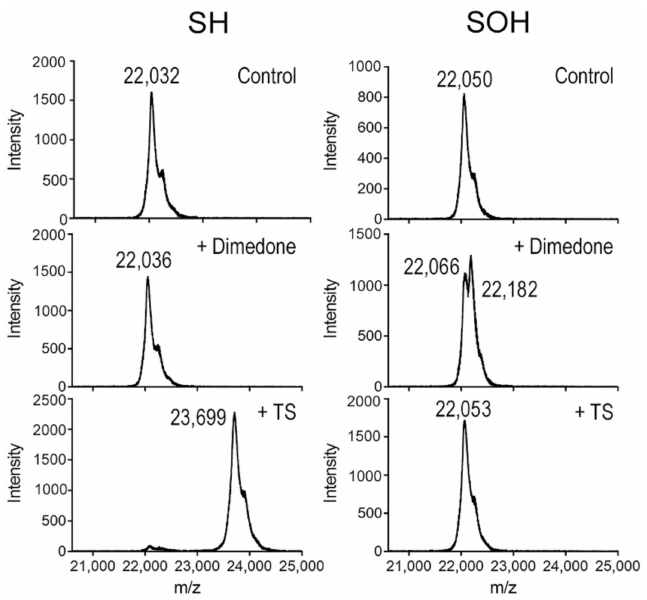
Figure 4. TS reacts with reduced Cys thiolate in PRX3, but not the sulfenic acid intermediate. MALDI- TOF MS analysis of the reaction of TS with untagged engineered dimer of PRX3 C229S in different oxidation states. Pre-reduced, untagged PRX3 engineered dimer lacking the Cys-S R residue was oxidized with 1.5 equivalents of H 2 O 2 to form a stable sulfenic acid intermediate. PRX3 with a thiol (SH) or sulfenic acid (SOH) were split and incubated with 1% DMSO (control), 20 mM dimedone, or 0.2 mM thiostrepton. Dimedone was added to confirm that sulfenic acid was present only in the samples treated with H 2 O 2